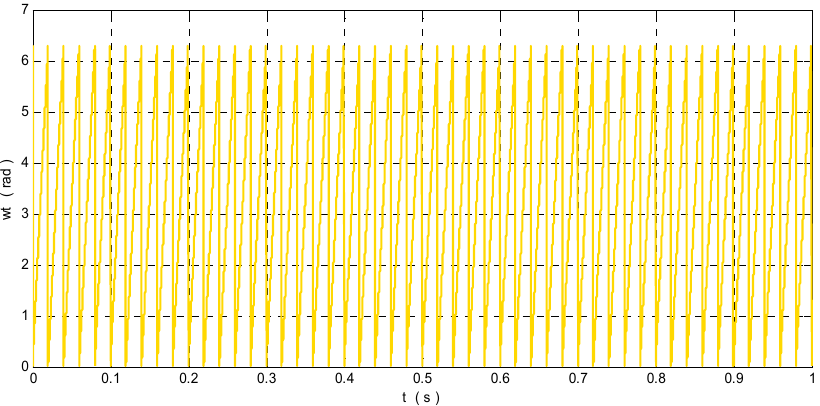
Figure 15. The simulation of the frequency of the proposed system.